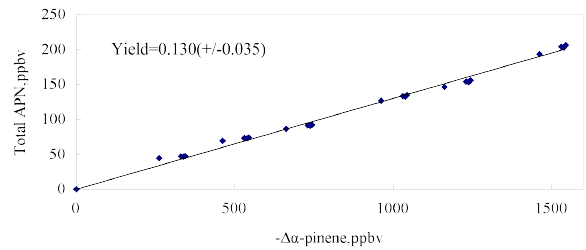
Fig. 5. Total α-pinene nitrate yield. Total[APN] is plotted vs. the loss of α-pinene over time. Fig. 5. Total α -pinene nitrate yield. Total [APN] is plotted vs. The data plotted are from multiple experiments. the loss of α -pinene over time. The data plotted are from multiple